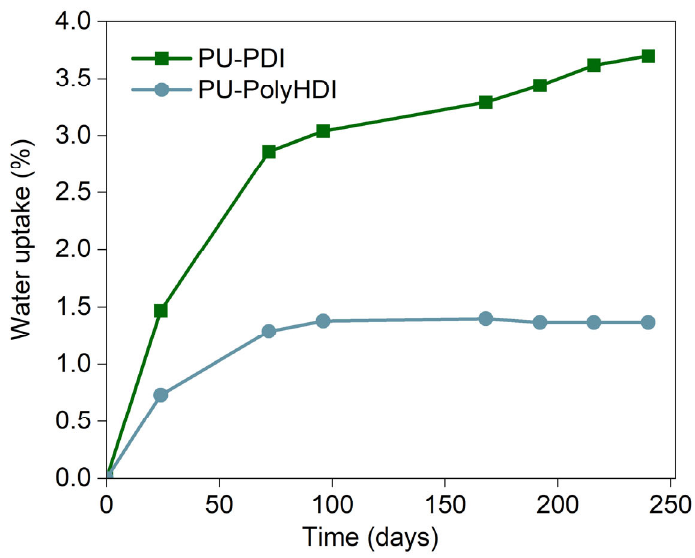
Figure 2. Average water uptake vs. immersion time at 30 ◦ C for PU-PDI and PU-PolyHDI samples.